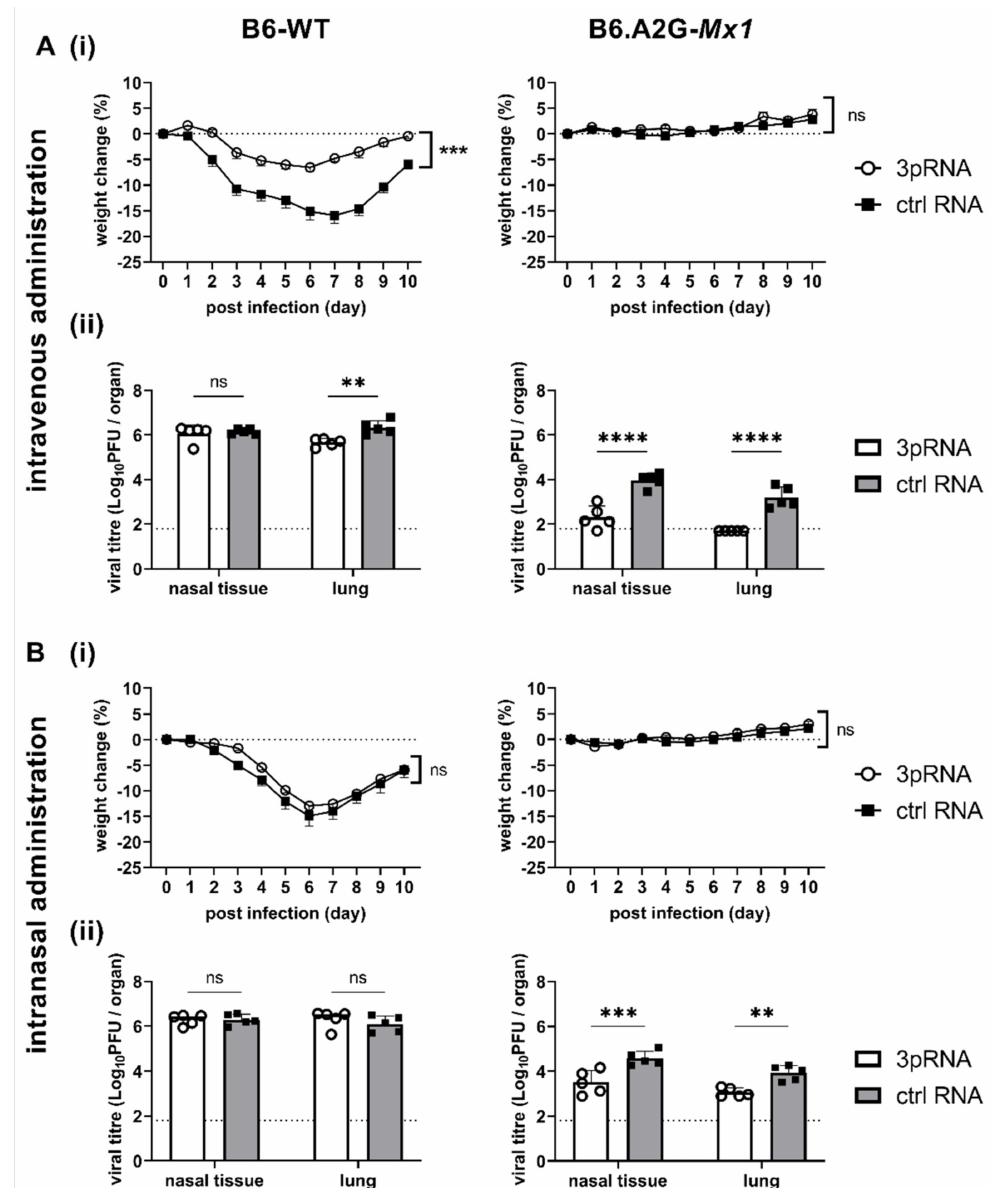
Figure 3. Intravenously applied RIG-I agonists provide superior protection from IAV HKx31 infection than intranasal treatment in B6.A2G- Mx1 mice. ( A ) B6-WT (left) and B6.A2G- Mx1 mice (right) received a single i.v. ( A ) or i.n. ( B ) treatment of 12.5 µ g RIG-I agonist (3pRNA) or control RNA